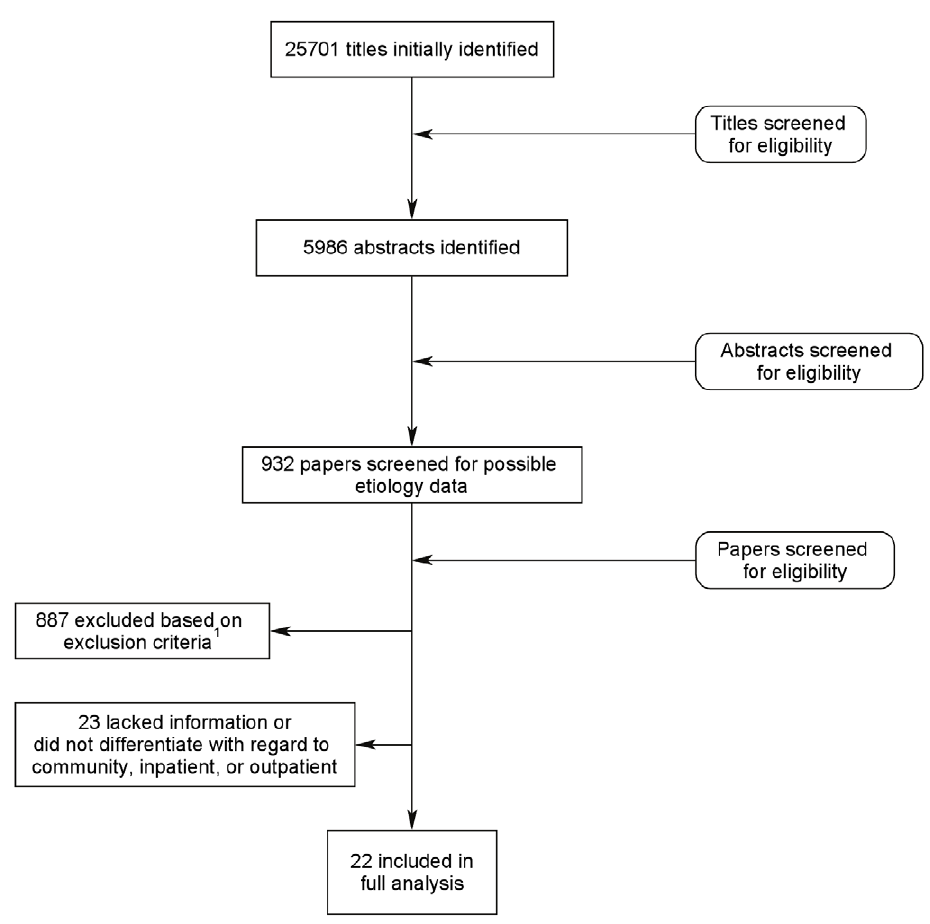
Figure 1. Results of systematic literature review.